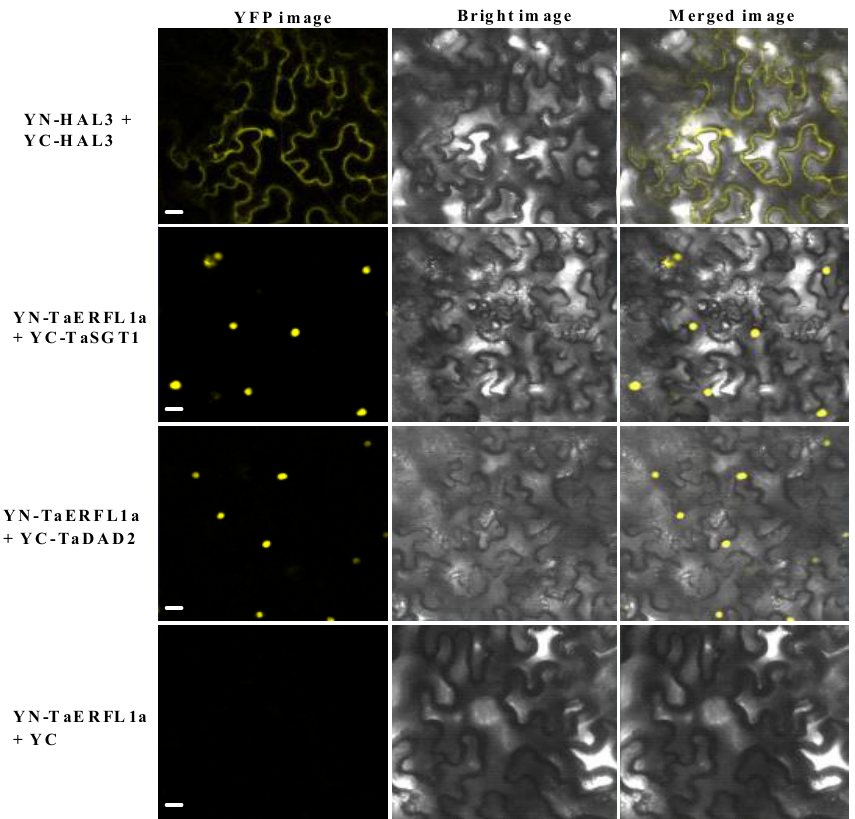
Figure 7. BiFC assay of the interaction between TaERFL1a and TaSGT1, or between TaERFL1a and TaDAD2 proteins in tobacco leaves. The YN-TaERFL1a and YC-TaSGT1 or YC-TaDAD2 constructs were co-infiltrated in tobacco. The YFP fluorescence was detected by confocal laser scanning microscopy. Co-transformants of YN-HAL3 and YC-HAL3 as well as YN-TaERFL1a and YC were used as positive and negative controls, respectively. Bar = 20 μm.